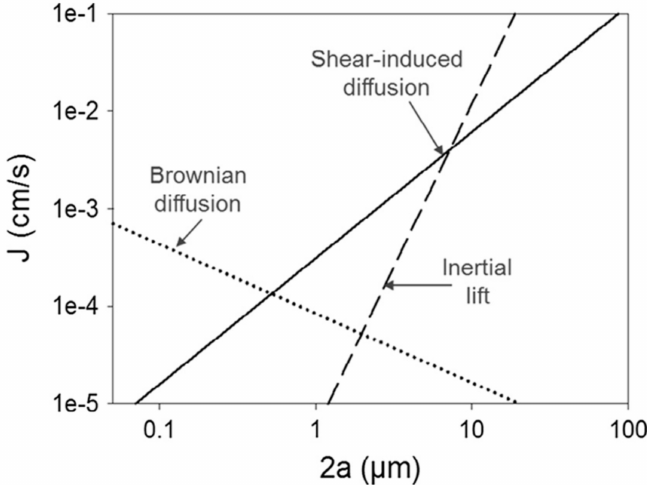
Figure 1. Flux versus the particle diameter for different migration mechanisms (Graph is reprinted from Separation and Purification Technology, 174, Karin Schroën; Anna van Dinther and Regine Stockmann, Particle migration in laminar shear fields: A new basis for large scale separation technology?, 372–388, 2017, with permission from Elsevier, original is from Davis